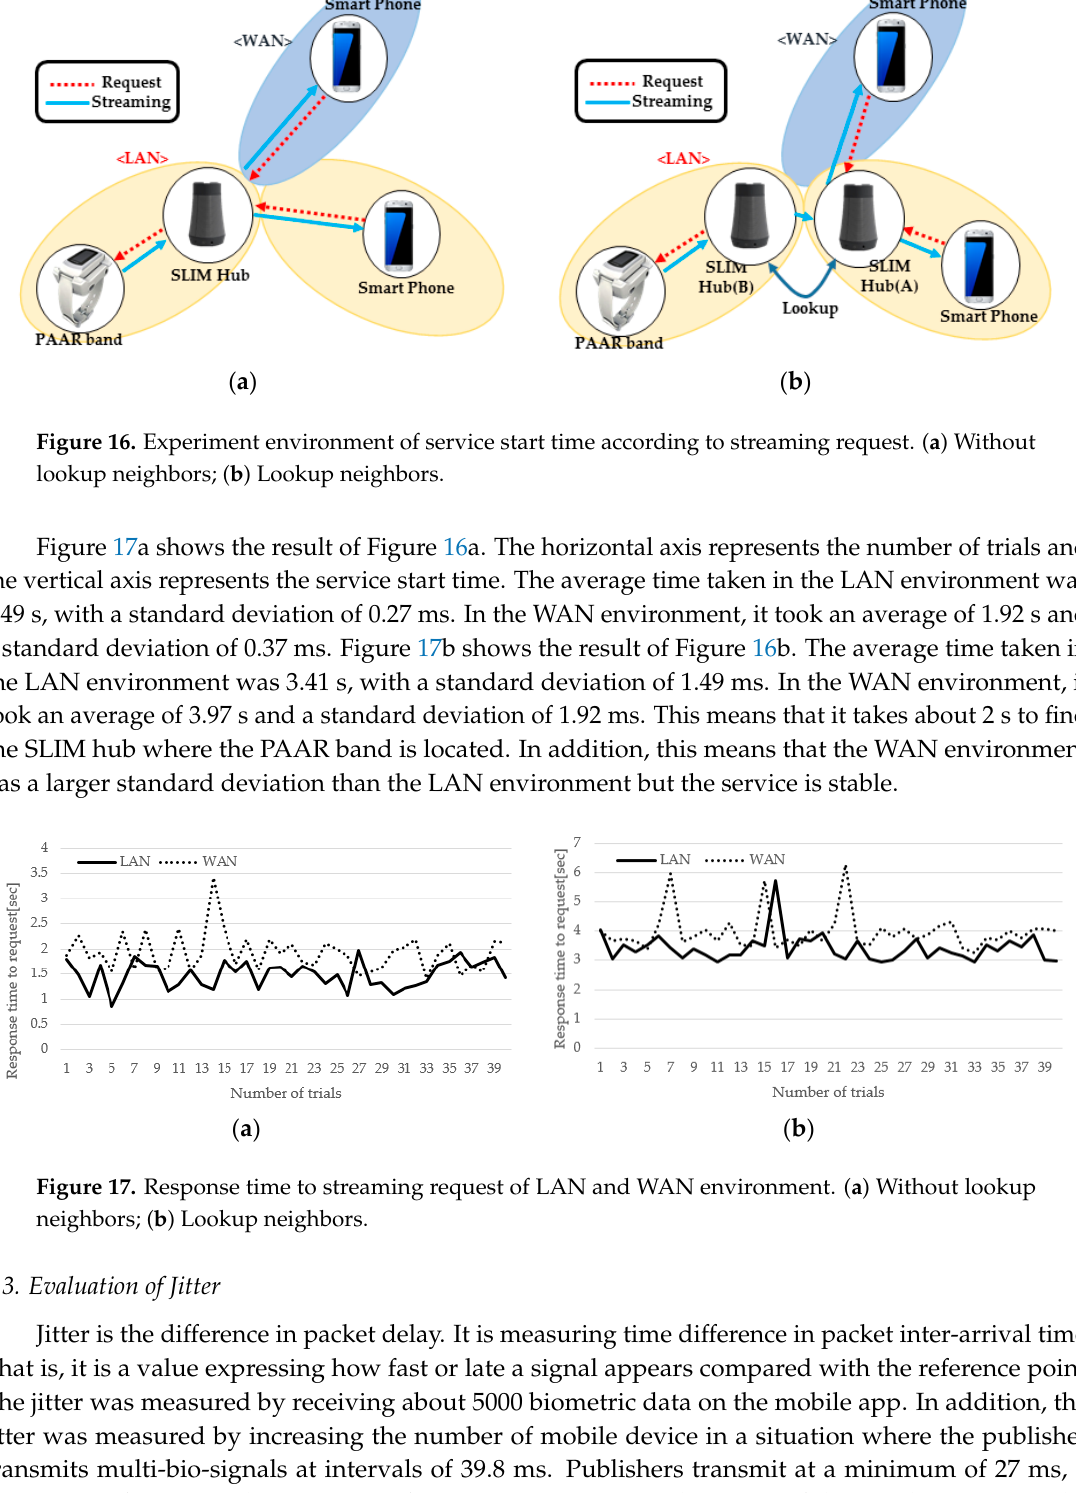
Figure 17. Response time to streaming request of LAN and WAN environment. ( a ) Without lookup neighbors; ( b ) Lookup neighbors.